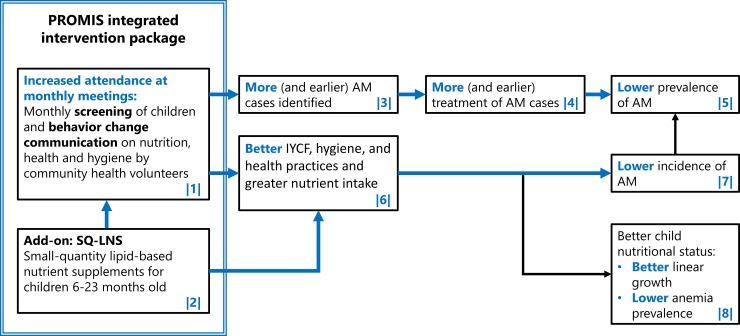
Theory of change of the PROMIS intervention.Hypothesized impacts of the intervention presented in this paper are shown in blue. The blue box represents the intervention. AM, acute malnutrition; IYCF, infant and young child feeding; PROMIS, Innovative Approaches for the Prevention of Childhood Malnutrition; SQ-LNS, small-quantity lipid-based nutrient supplement.